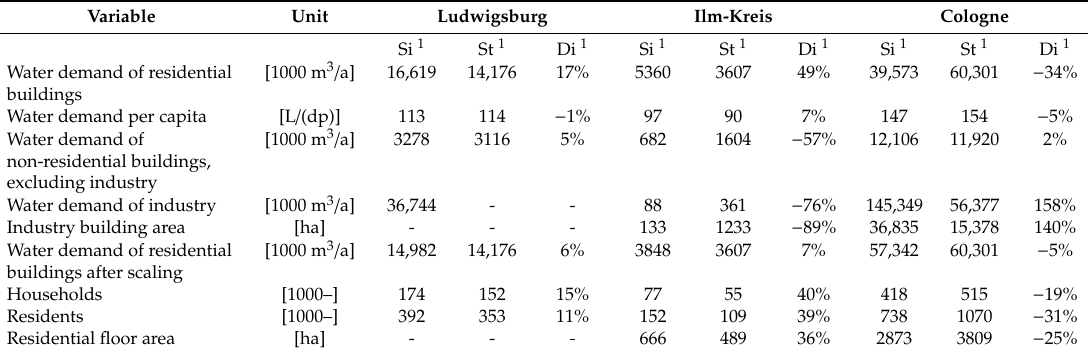
Table 7. Key validation